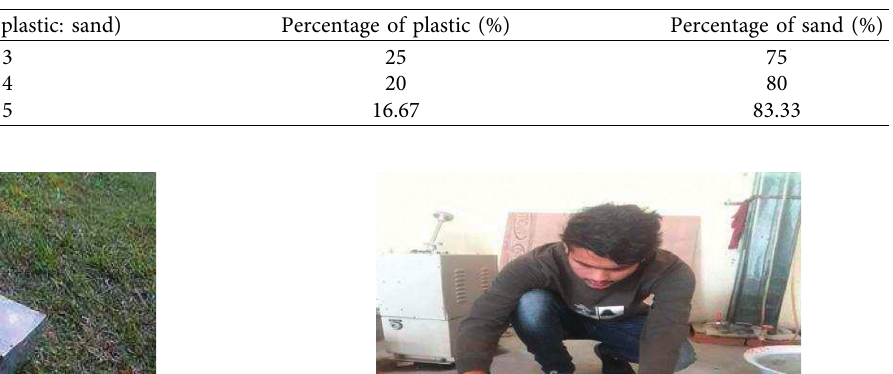
Figure 5: Semilog graph. Table 2: Mix ratio.